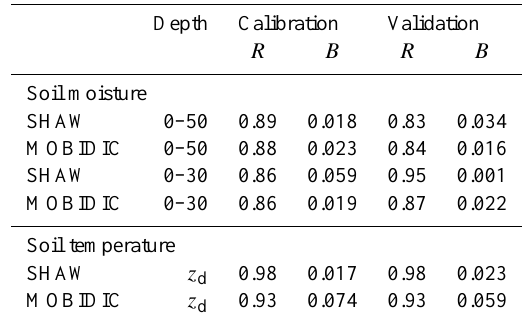
Table 4. Performance of the SHAW and MOBIDIC models of Site 1 for the calibration period (years 2007 and 2008) and validation period (year 2009).